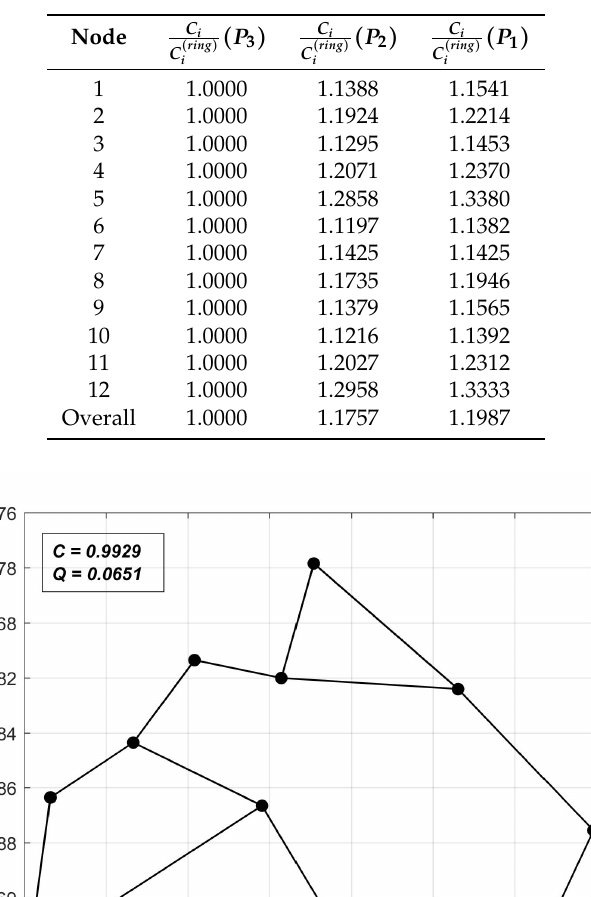
Table 4. Relative gains (weight optimization).